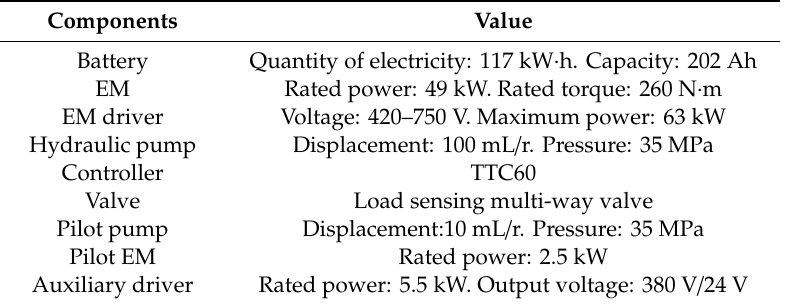
Table 4. Parameters of components in the system.